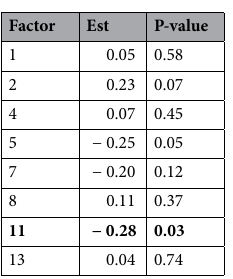
Table 7. Association of metabolite factor levels with T2DM status. Significant values are in